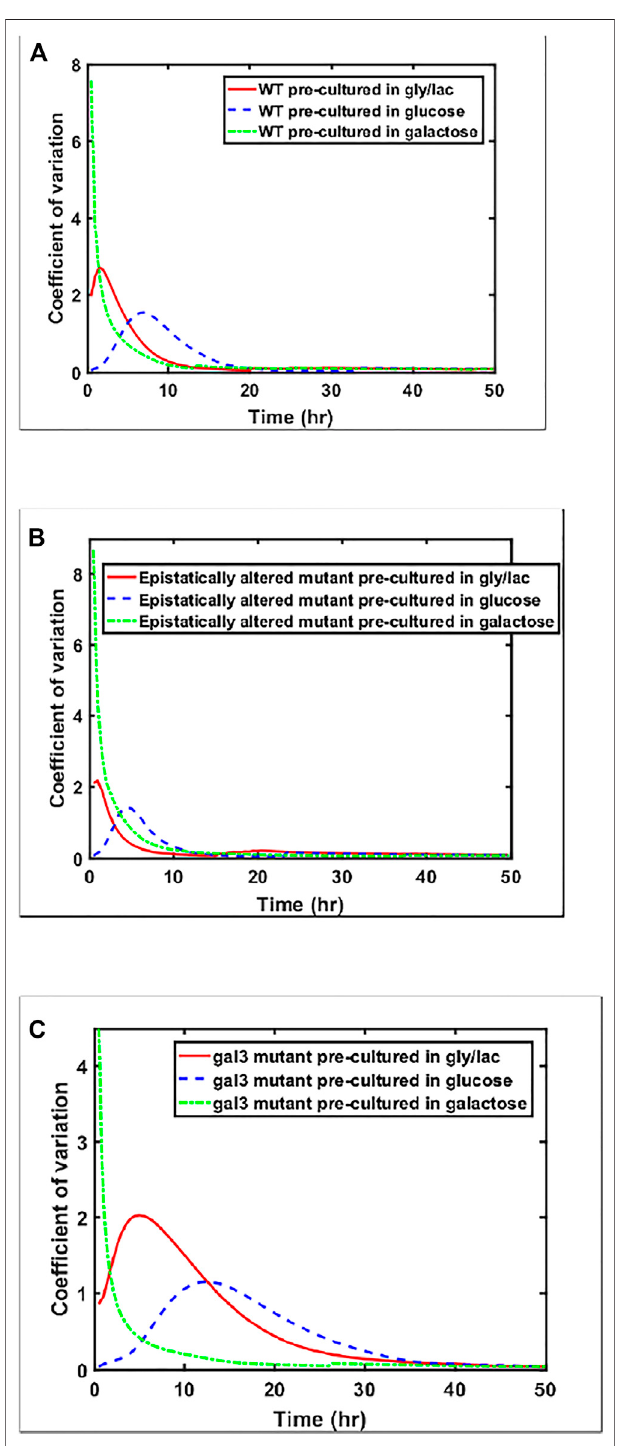
FIGURE 6 | Coef fi cient of variation in GAL1 expression levels, shown for (A) wild type, (B) Epistatically-altered strain, and (C) gal3 Δ strain when grown in different environmental cell-cell heterogeneity in the system ( Figure 3C ). At intermediate times, a fraction of the cells are in the ON state, and the rest of the population is in the OFF state. This heterogeneous induction